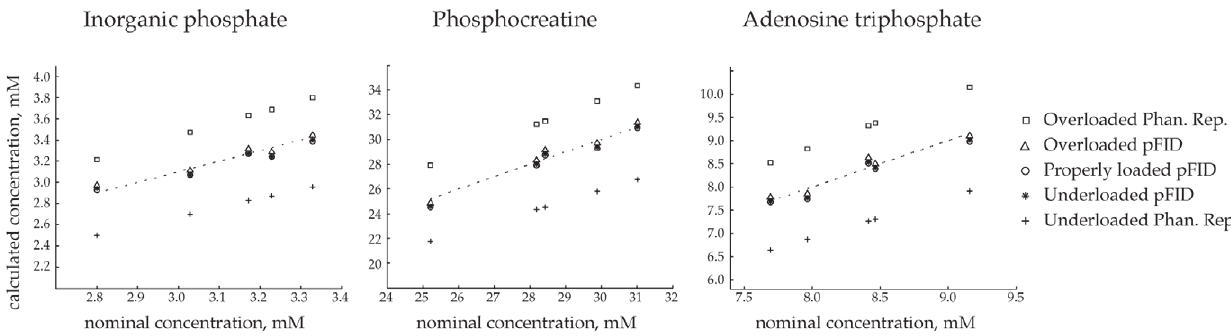
Figure 3. Concentrations determined by the pFID method are accurate and independent of coil loading conditions. The nominal concentrations (x-axes) were determined using the phantom replacement method and calibration measurements obtained from a phantom that replicated in vivo coil loading conditions. The nominal concentrations reflect the normal ranges of Pi, PCr and ATP expected in healthy male subjects. All three sets of pFID measurements fall very close to the lines of identity (dashed lines), validating that this method allows accurate quantification of metabolite content for a wide range of coil loading conditions. In contrast, the concentrations determined using the phantom replacement method were invalid when in vivo coil loading conditions were not replicated in the calibration session. When the calibration phantom overloaded the coil, the phantom replacement method overestimated the in vivo concentrations. When the phantom underloaded the coil, the phantom replacement method underestimated the in vivo